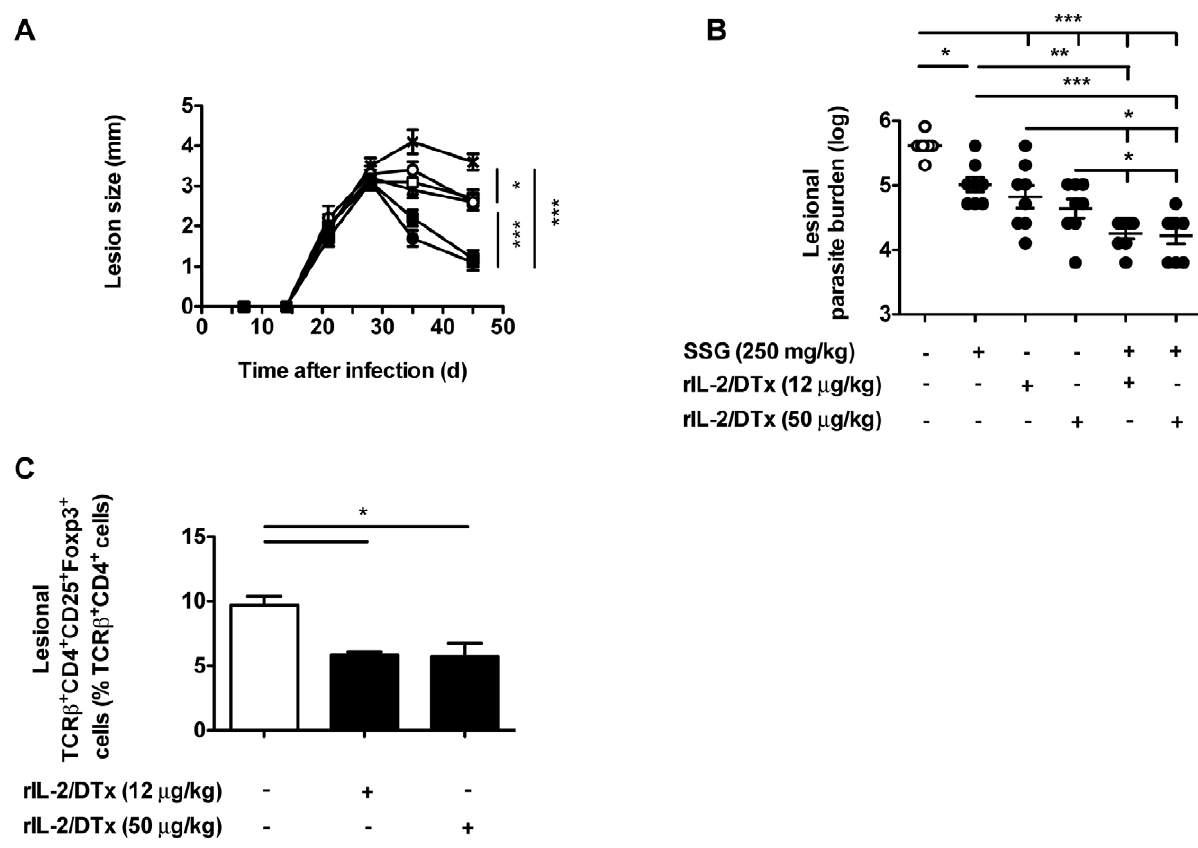
Figure 3. Combined rIL-2/DTx and sodium stibogluconate treatment provides additive efficacy in experimental L.major infection. C57BL/6 mice were infected as in Figure 2. Beginning 30 d after infection, mice were treated: (1) daily for 10 d with SSG (250 mg/kg; filled triangles); (2) three times at 5 d intervals with rIL-2/DTx (12 m g/kg; open squares); (3) three times at 5 d intervals with rIL-2/DTx (50 m g/kg; open circles); (4) daily for 10 d with SSG (250 mg/kg) plus three times at 5 d intervals with rIL-2/DTx (12 m g/kg; filled squares); or (5) daily for 10 d with SSG (250 mg/kg) plus three times at 5 d intervals with rIL-2/DTx (50 m g/kg; filled circles); or (6) with normal saline (per route and schedule for 10 d SSG plus 3 doses of rIL-2/DTx; crossed symbols). ( A ) Lesion size, ( B ) lesional parasite burden, and ( C ) lesional T reg percentage were quantified in the indicated groups, 45 d after infection. Data represent means + / 2 SE of 8 mice/group in a single experiment (with individual data points shown for parasite burden); n =8 ( A and B ), n =4 ( C ). ( A ) MANOVA P , 0.05; ( A–C ) ANOVA P , 0.02; Tukey’s correction; * P , 0.05, ** P , 0.01, *** P ,